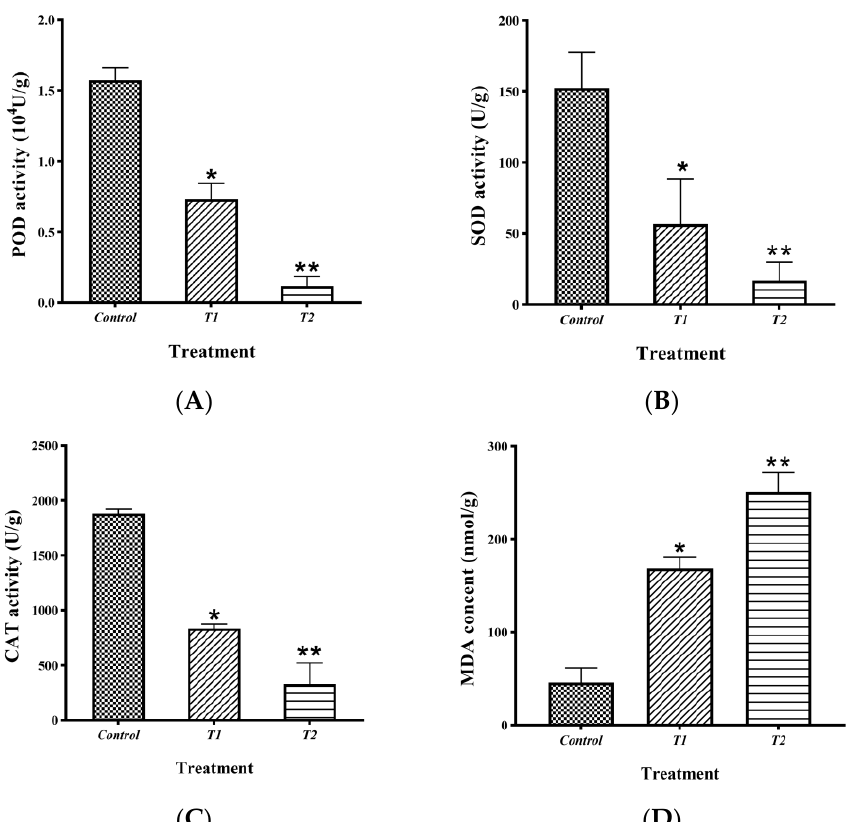
Figure 6. Effect of lipopeptide crude extracts on the antioxidant activity of B. sorokiniana mycelia. Control (equal volume PBS treatment), T1 (1% crude extract), T2 (2% crude extract). ( A ) Superoxide dismutase (SOD) activity, ( B ) peroxide (POD) activity, ( C ) catalase (CAT) activity, ( D ) malondialdehyde (MDA) content. Data are presented as the average ± the standard deviation. * and ** indicates a significant difference between treatment groups within a parameter (Duncan’s multiple range test at p ≤ 0.05 and p ≤ 0.01, respectively).